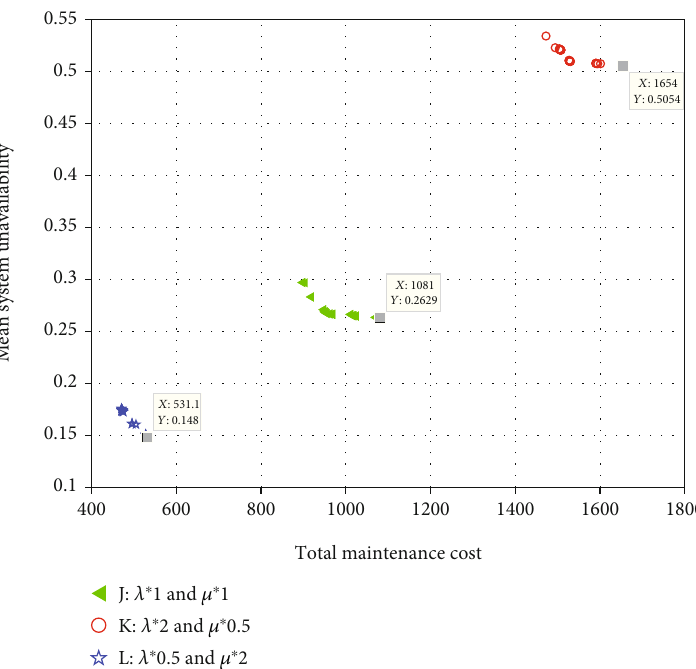
Figure 17: Pareto frontier for fourth-level human reliability.